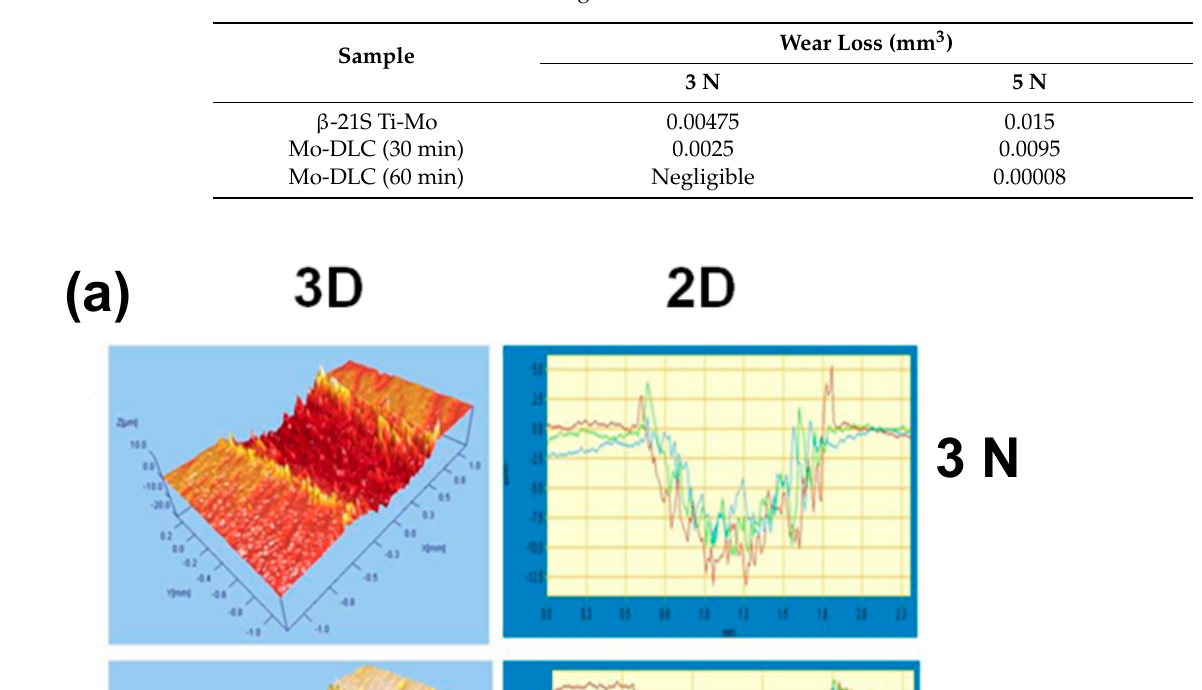
Table 3. Estimated wear losses during tribometric measurements for two different loads.